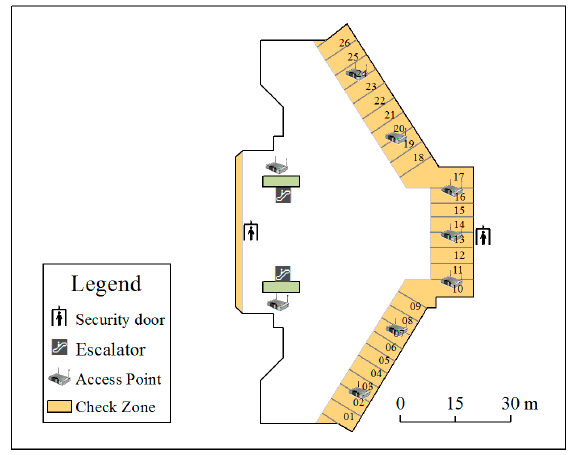
Figure 5. General overview of the queue zone and the locations of the APs.